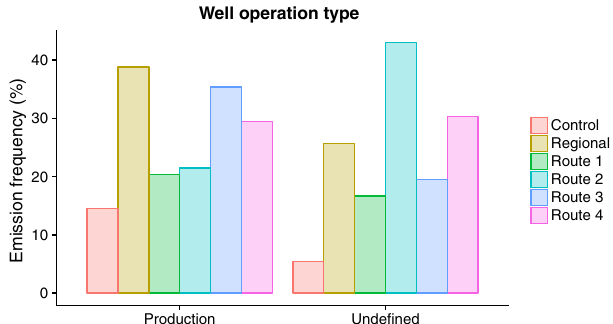
Figure 7. Emission frequencies for each well operation type for all surveyed infrastructure on each route. Certain operation types for which we did not have representative samples are not included (such as injection and disposal wells).